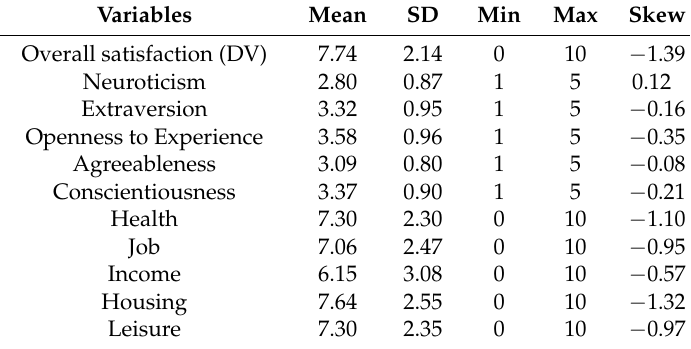
Table 4. Mean, standard deviation, minimum, maximum, and skew values of personality (BFI-10) and satisfaction variables for Survey 2; DV = Dependent variable. ( N = 4784 except for variable job: N =